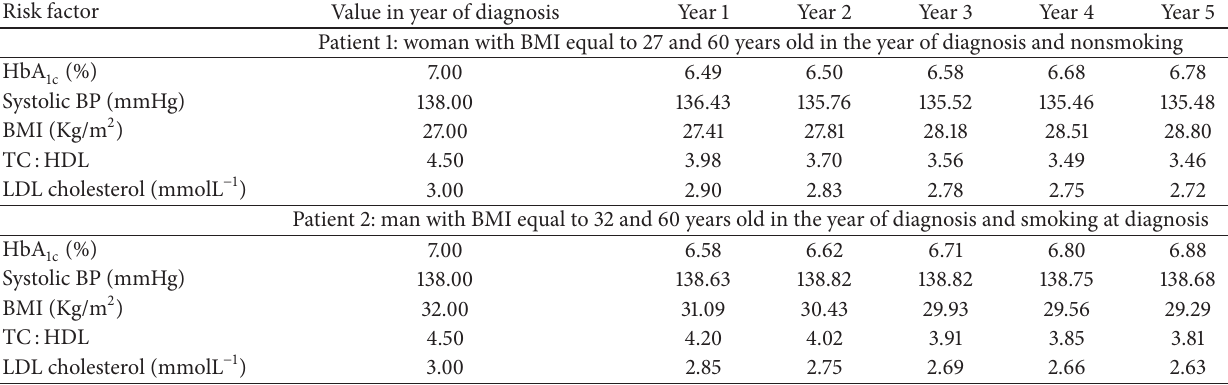
Table 3: Prediction of risk factors for two hypothetical patients over 5 years after the